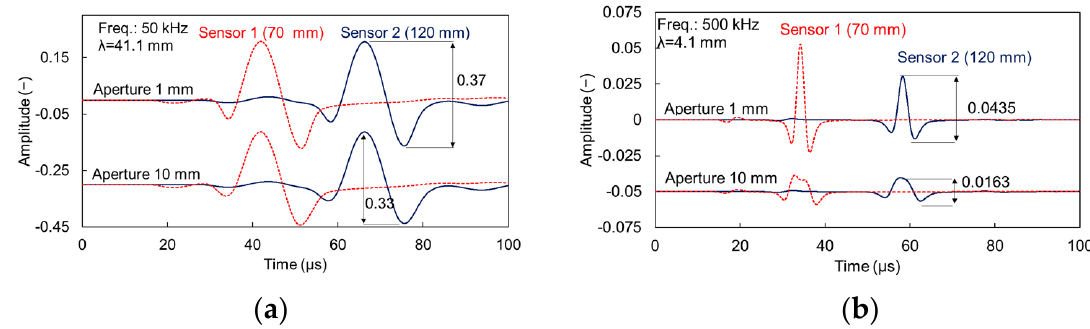
Figure 5. Simulated waveforms on homogeneous cement matrix for different apertures and excitation frequency of ( a ) 50 and ( b ) 500